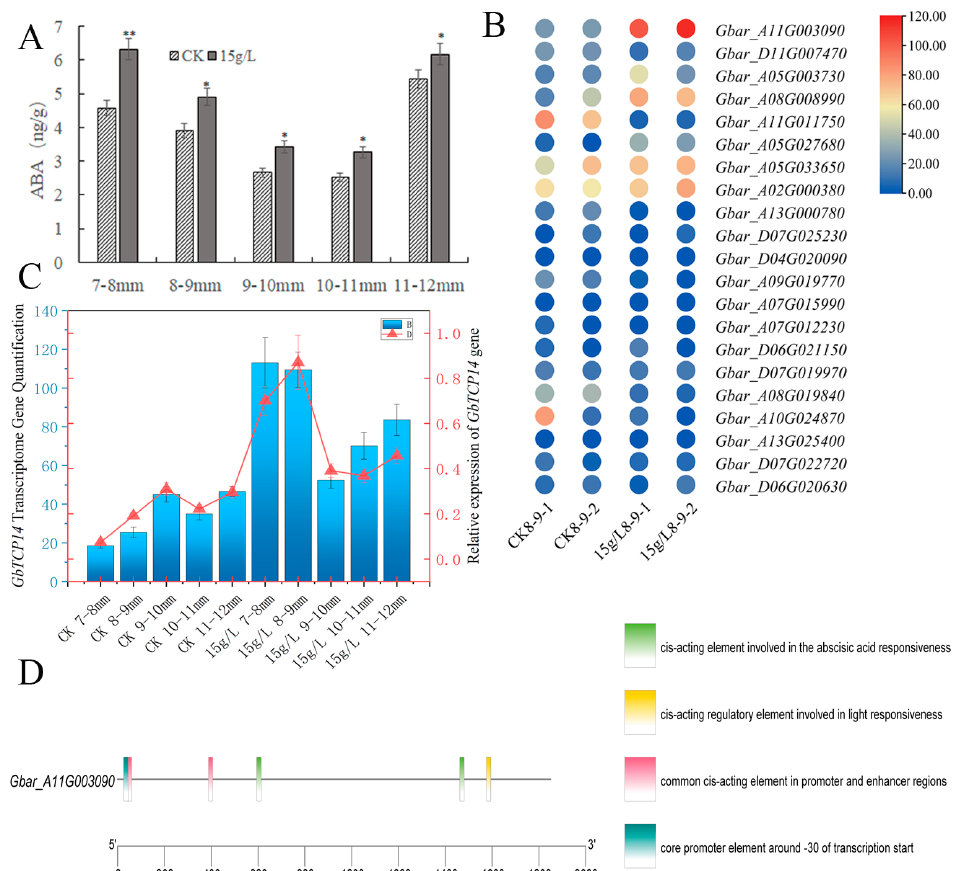
Figure 7. Abscisic acid content in anthers and the expression of abscisic acid response-related genes in glyphosate-treated and control groups. ( A ) Abscisic acid content in anthers of different-lengthed buds. * indicates a significance level of p < 0.05 and ** indicates an extremely significant level of p < 0.01. ( B ) Expression heatmap of the abscisic acid response-related genes in anthers of 8 – 9 mm buds. ( C ) Expression of GbTCP14 gene in transcriptome with qRT–PCR. ( D ) Promoter analysis of the Gbar_A11G003090